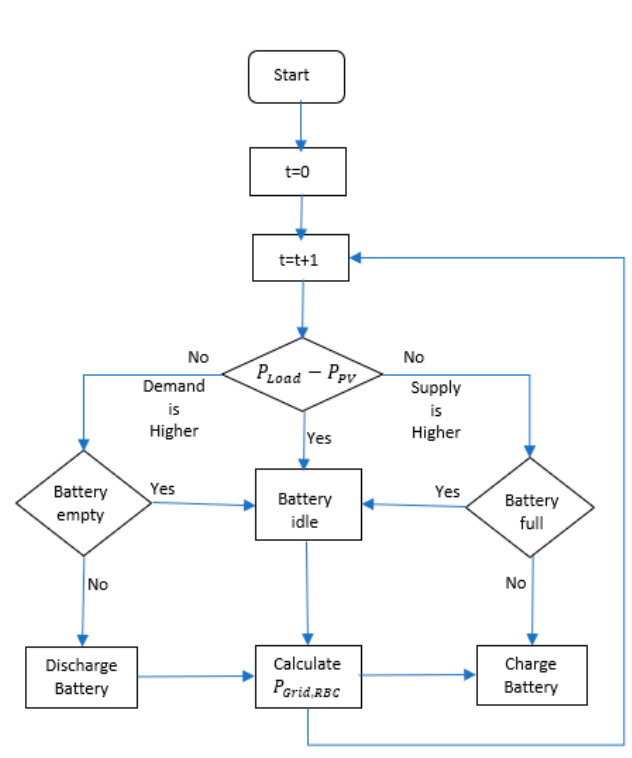
Figure 7. Rule-based control flowchart [56].